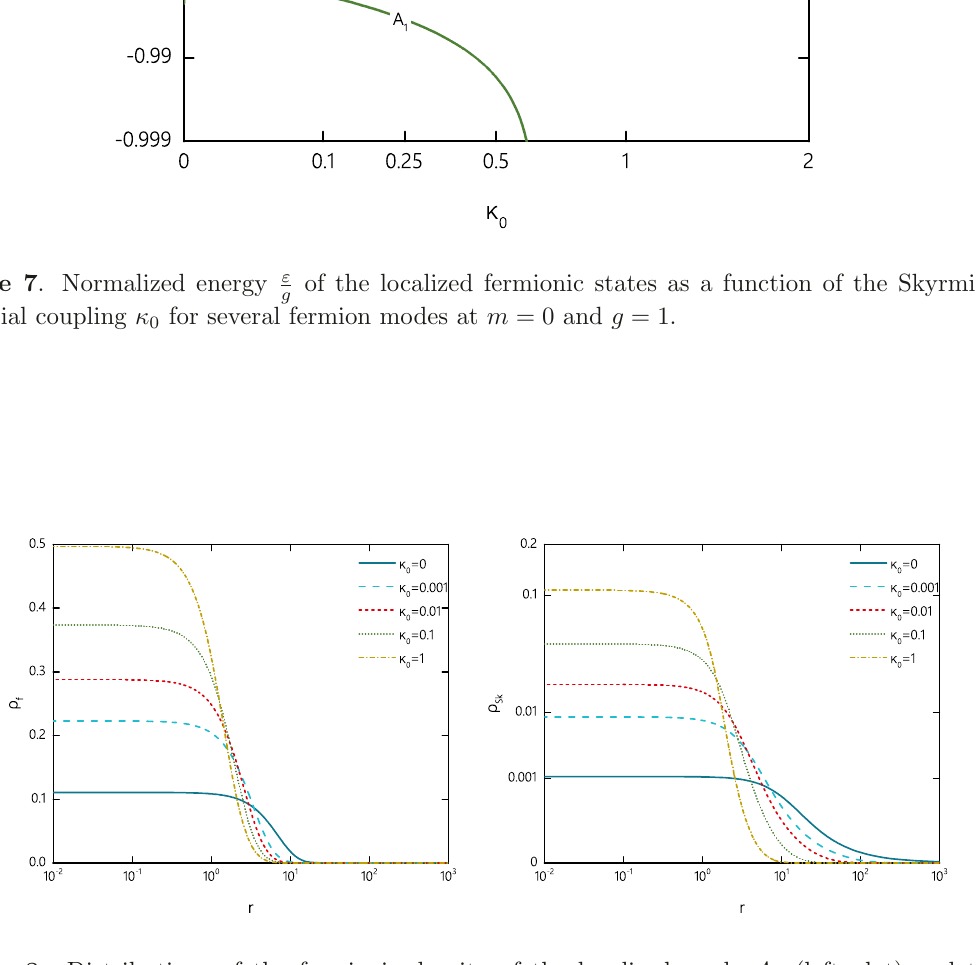
Figure 8 . Distributions of the fermionic density of the localized mode A 0 (left plot) and the topological density of the Skyrmion coupled to this mode (right plot) as functions of the radial coordinate r for some set of values of the coupling κ 0 at m = 0 and g =